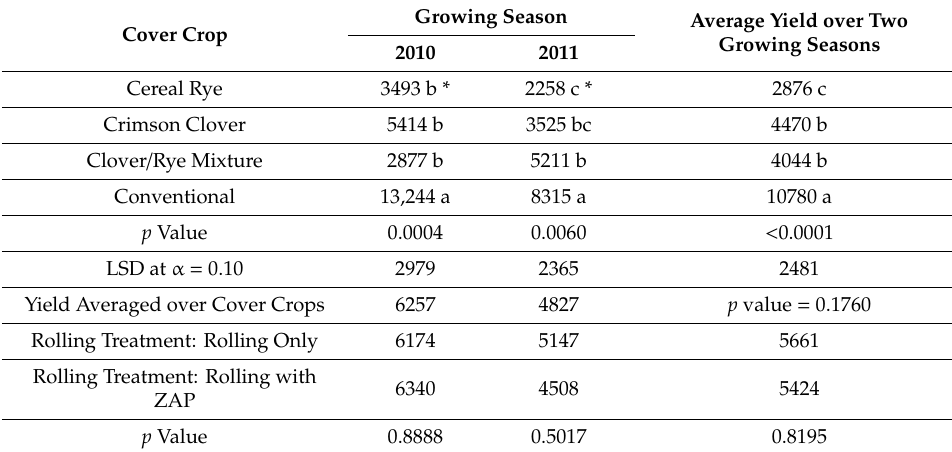
Table 9. Watermelon yield (kg ha − 1 ) with respect to cover crop treatments in 2010 and 2011 growing